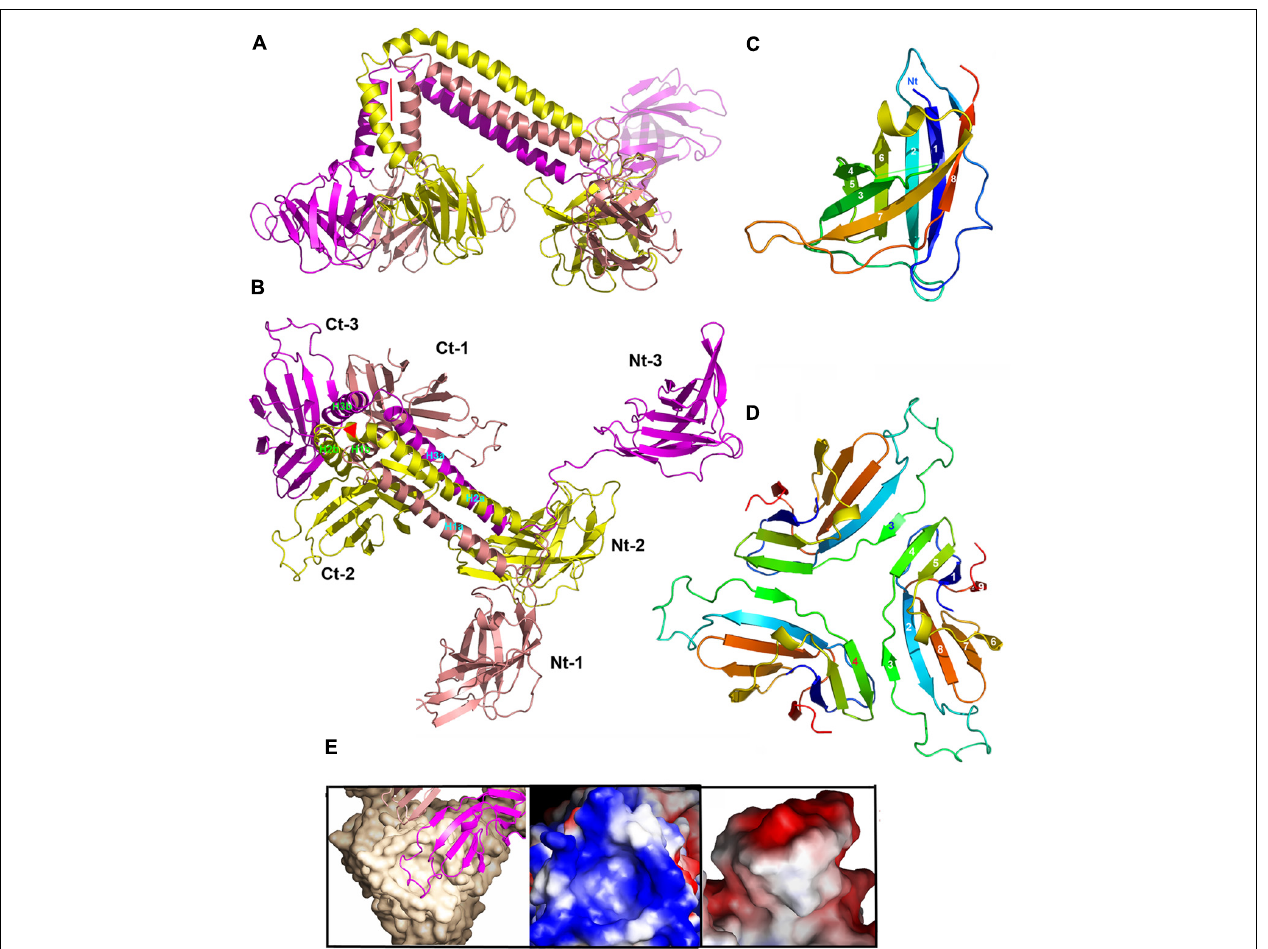
FIGURE 10 | Structures of components of phageTP901-1 baseplate. (A) Lateral ribbon view of the ORF48 trimer (salmon, yellow, and violet, for monomers 1, 2, and 3, respectively). (B) View 90 ◦ from (A) (top view) of ORF48 trimer. The N- and C-terminal domains are labeled, 1, 2, 3, respectively. (C) The ribbon view (rainbow colored) of the N-terminal domain of ORF48. (D) The ribbon view (rainbow colored) of a trimer of the